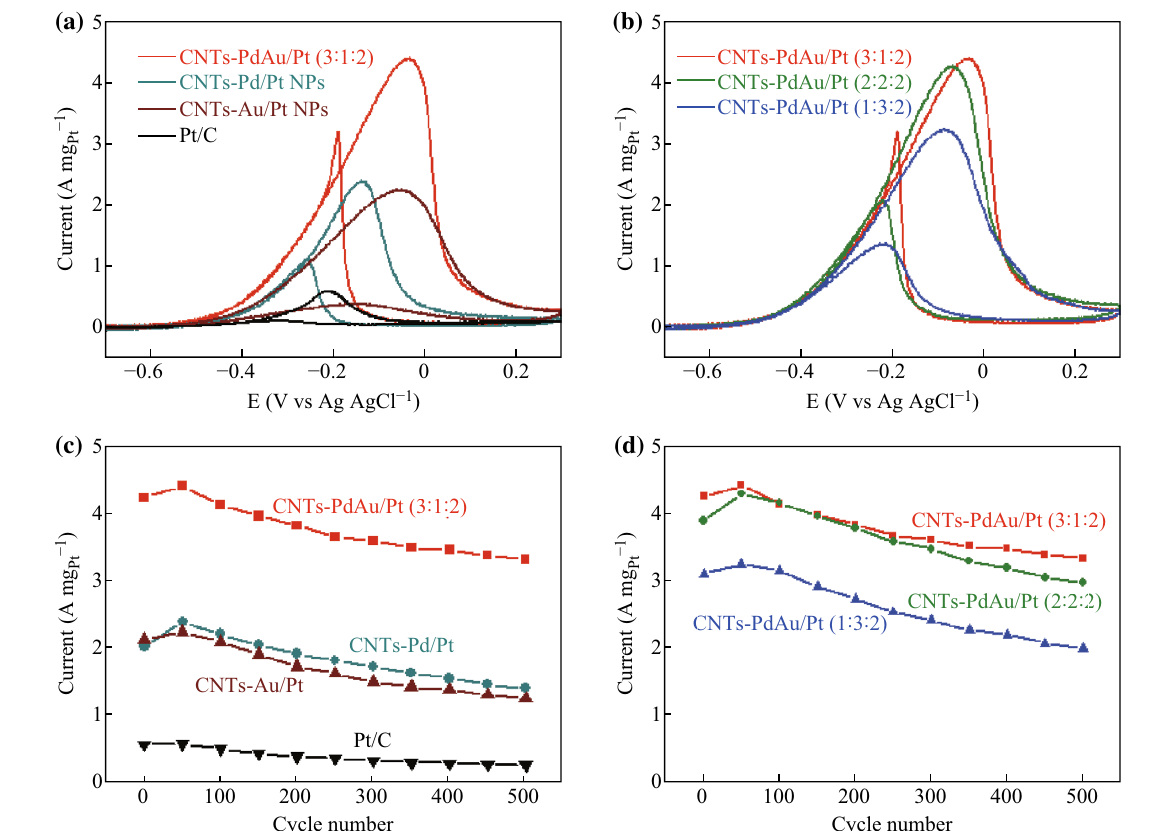
Fig. 7 CV curves for the MOR using: a CNTs-PdAu/Pt (3:1:2) NPs, Pd/Pt and Au/Pt bimetallic NPs, and a commercial Pt/C catalyst, and b CNTs-PdAu/Pt trimetallic NPs with different Pd/Au/Pt ratios. The durability (500 cycles) of the oxidation peak current for: c samples shown in a ; and d samples shown in b